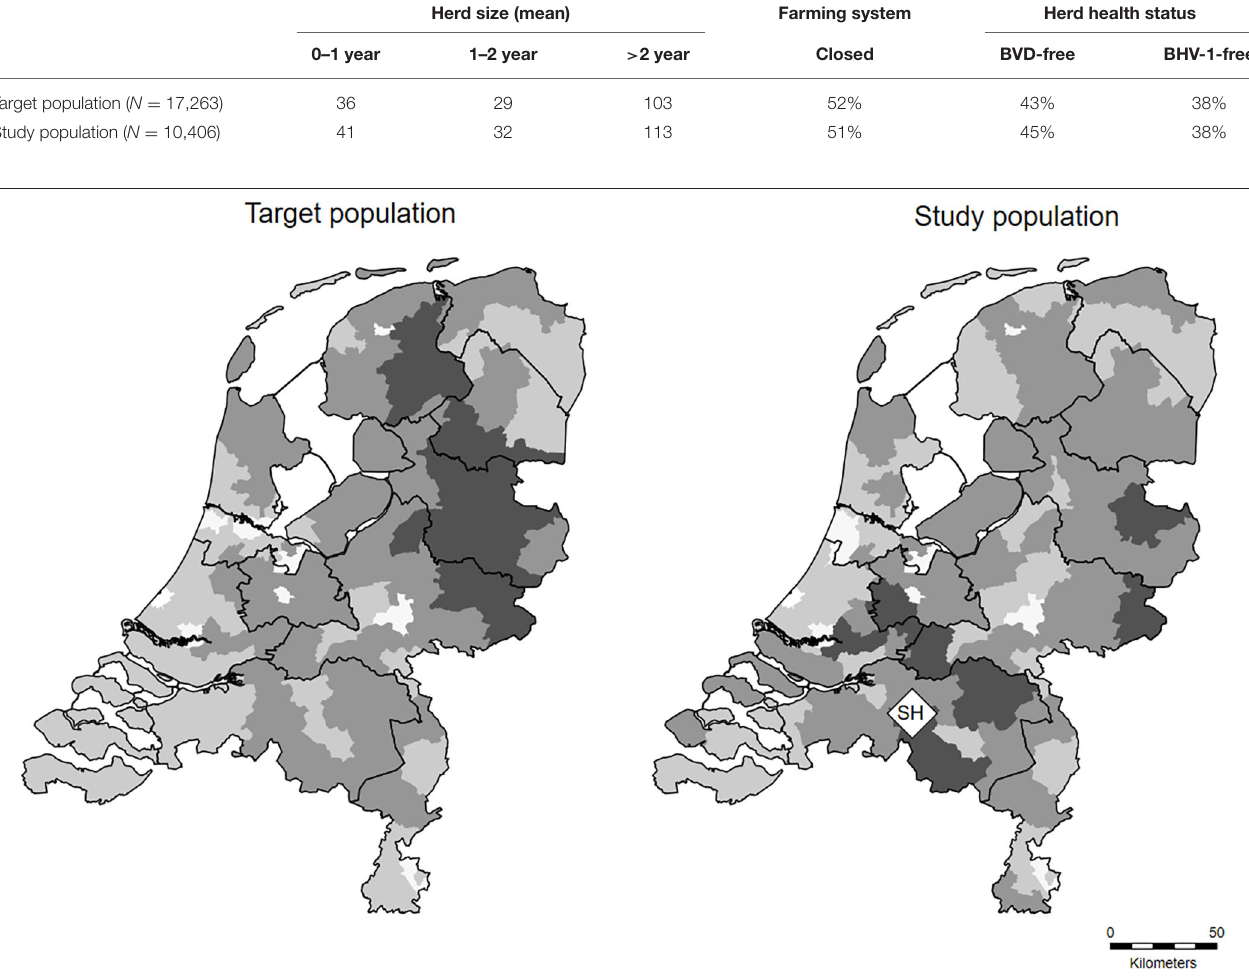
animal health indicators in the TASC (1). The model can be formulated as: